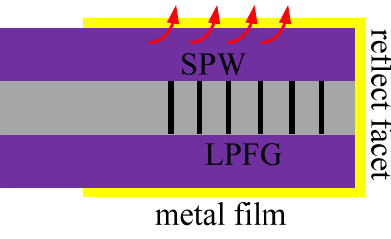
Figure 13. The structure of the reflected LPFG-SPR sensors [52,53].